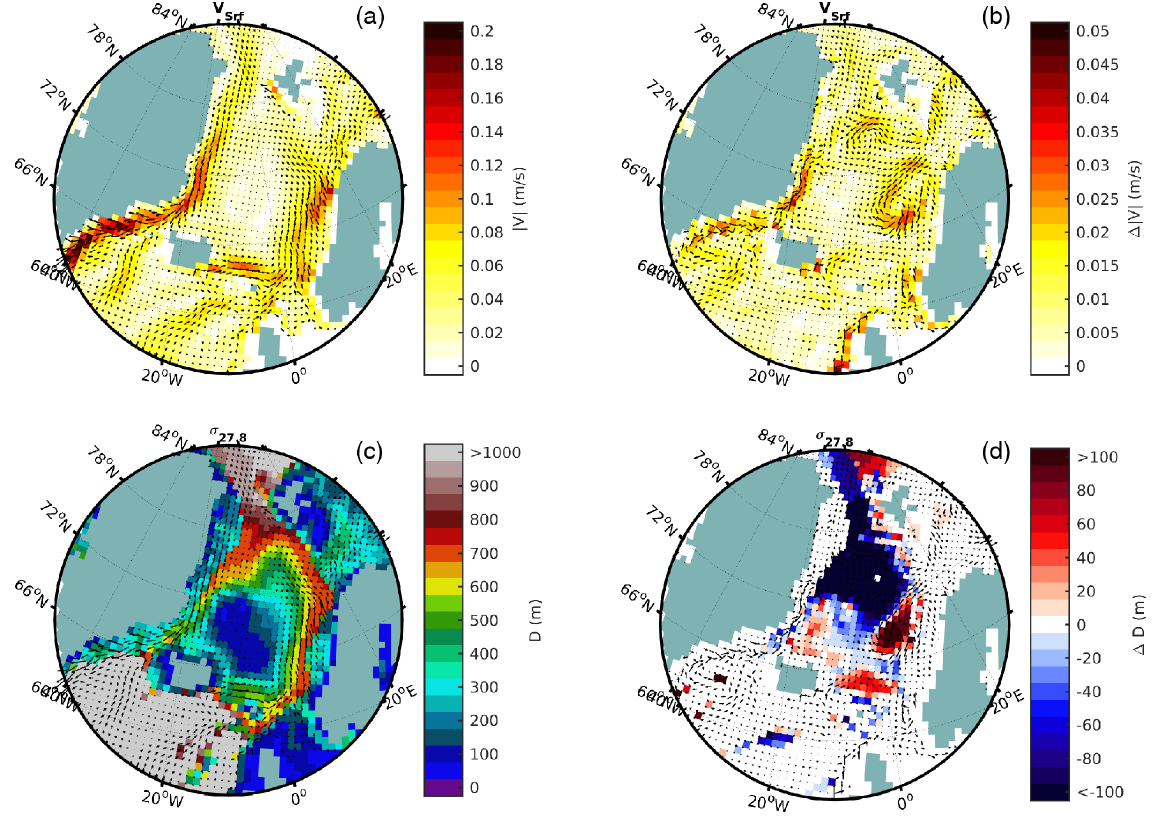
Figure 5. Modelled average winter (JFM) circulation at approx. 100m depth (a) and average depth of the 27.8kg × m − 3 isopycnal (c) in the Nordic Seas for the period 1996–2010. The anomalous circulation pattern (b) and depth changes of the 27.8kg × m − 3 isopycnal (d) describe the response to the JFM 2003 conditions relative to the average. Vectors in (c) and (d) correspond to average (a) and anomalous (b) circulation patterns,